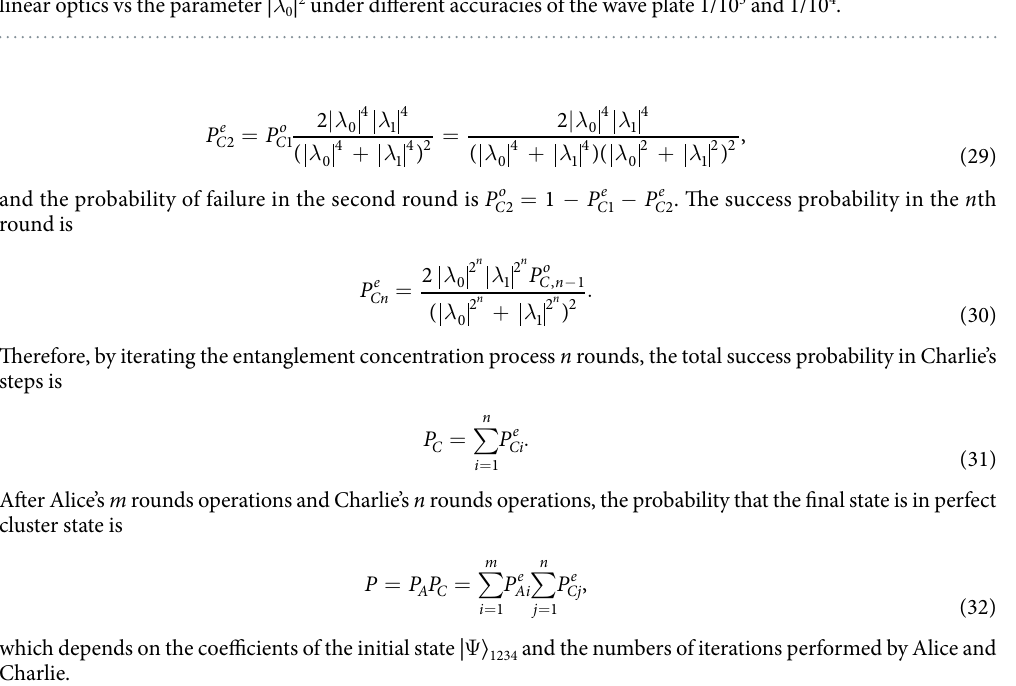
Figure 4. ( a ) The success probability of the ECP with linear optics vs the parameters | λ 0 | 2 in the range [0,0.25]. ( b ) The distribution of the number of possible initial cluster states that can be concentrated by the ECP with linear optics vs the parameter | λ 0 | 2 under different accuracies of the wave plate 1/10 3 and 1/10 4